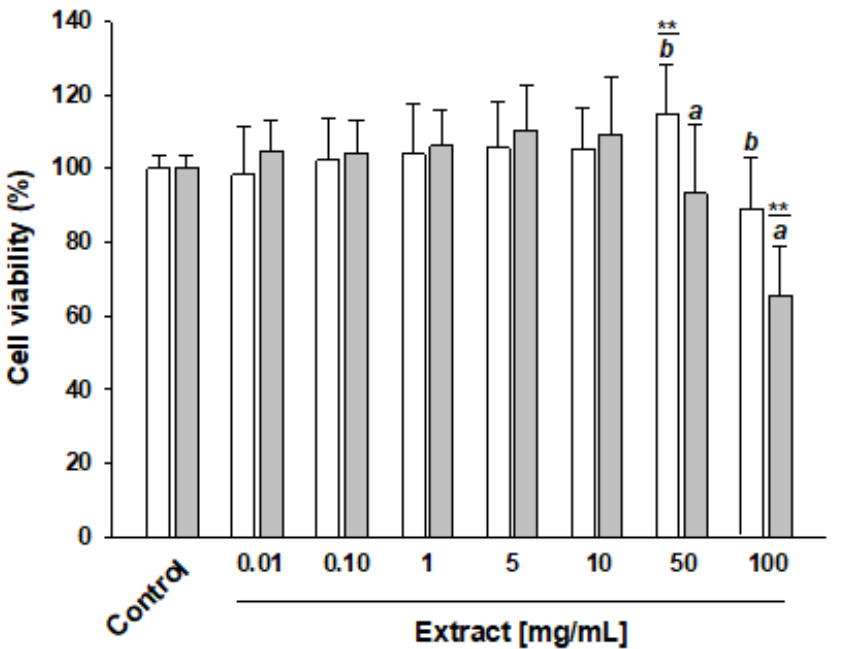
Figure 2. Effect of PAW-rocket salad extract on Caco2 cell viability. Caco2 cells were treated for 5 h with increasing concentrations of polyphenols (0.01–100 mg/mL) extracted from PAW-20 (white bar) or UT (gray bar) rocket salad. Cell viability was determined by CellTiter-Glo ® Luminescent Cell Viability Assay (Promega). Control represents Caco2 cells incubated with culture medium containing 0.1% DMSO. Data are presented as the mean ± SD of relative percentage of control sample (set at 100%) obtained from two independent experiments each carried out in quadruplicate. Statistical significance was calculated by pairwise multiple comparisons for one-way ANOVA followed by Tukey’s HSD post hoc test. **: significant difference versus control p < 0.001; different letters, when reported, mean significant difference between groups (PAW-20 versus UT at different concentrations), p <